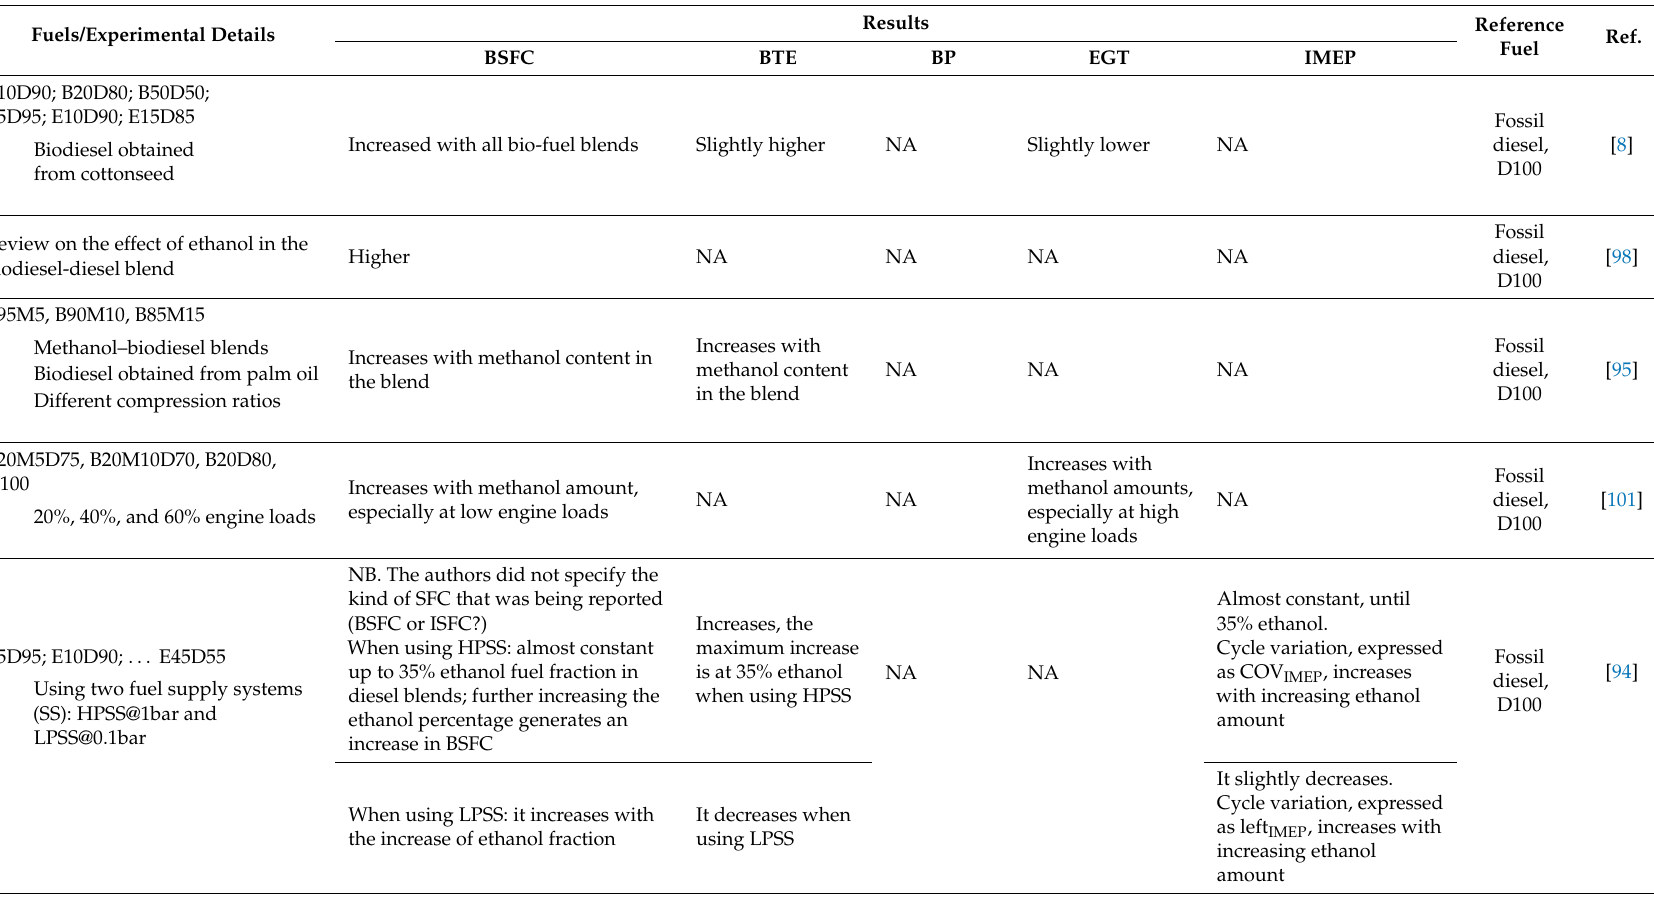
Table 8. Engine performances (regarding the BxMy/BxMyDz notation, it refers to a blend containing y% of methanol; see also Table 7). Fuels/Experimental